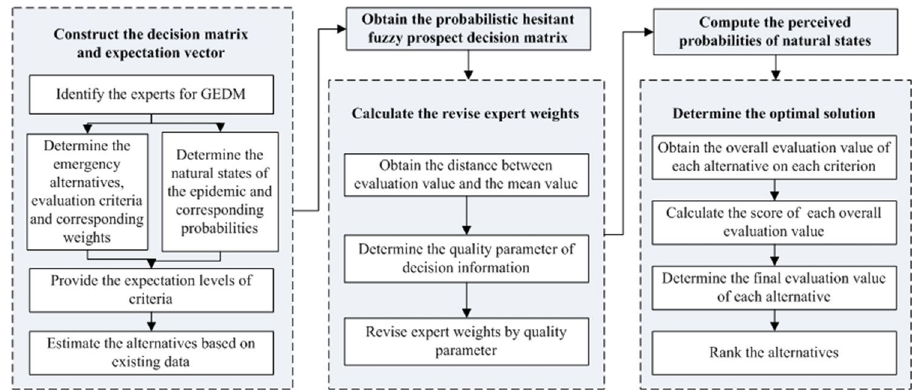
Fig. 2 Flowchart of the pro- posed